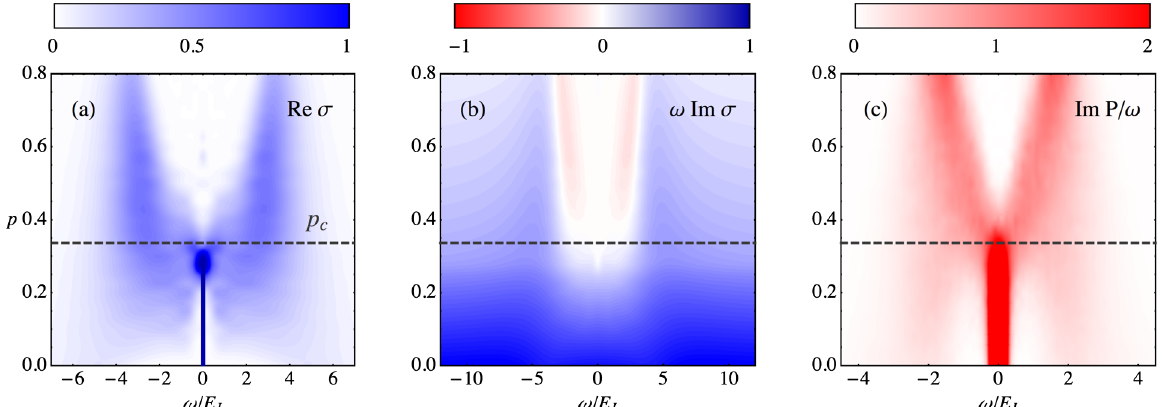
FIG. 4. Dynamical response functions across the disorder-tuned SIT. The critical disorder p c ¼ 0 . 337 is marked as a dashed line; T=E ¼ 0 . 156 , E =E ¼ 3 . 0 , and L ¼ 64 . (a) In the conductivity Re σ ð ω Þ , the superfluid response is evident as a zero-frequency delta J c J function of strength ρ s . Deep in the insulator, there is a gap in Re σ ð ω Þ that grows with disorder. (b) ω Im σ ð ω Þ shows a crossover from > 0 ] to “ capacitative ” [ ω Im σ ð ω Þ < 0 ] behavior at small ω across the transition. (c) The boson spectral “ inductive ” [ ω Im σ ð ω Þ ¼ ρ s function Im P ð ω Þ = ω , which has a peak centered about zero frequency in the superconductor, develops a characteristic scale ~ ω B in the insulator that grows with